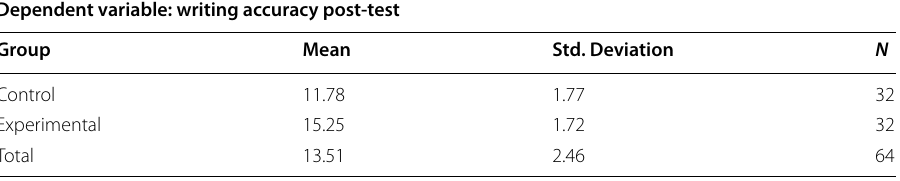
Table 1 Writing accuracy descriptive statistics